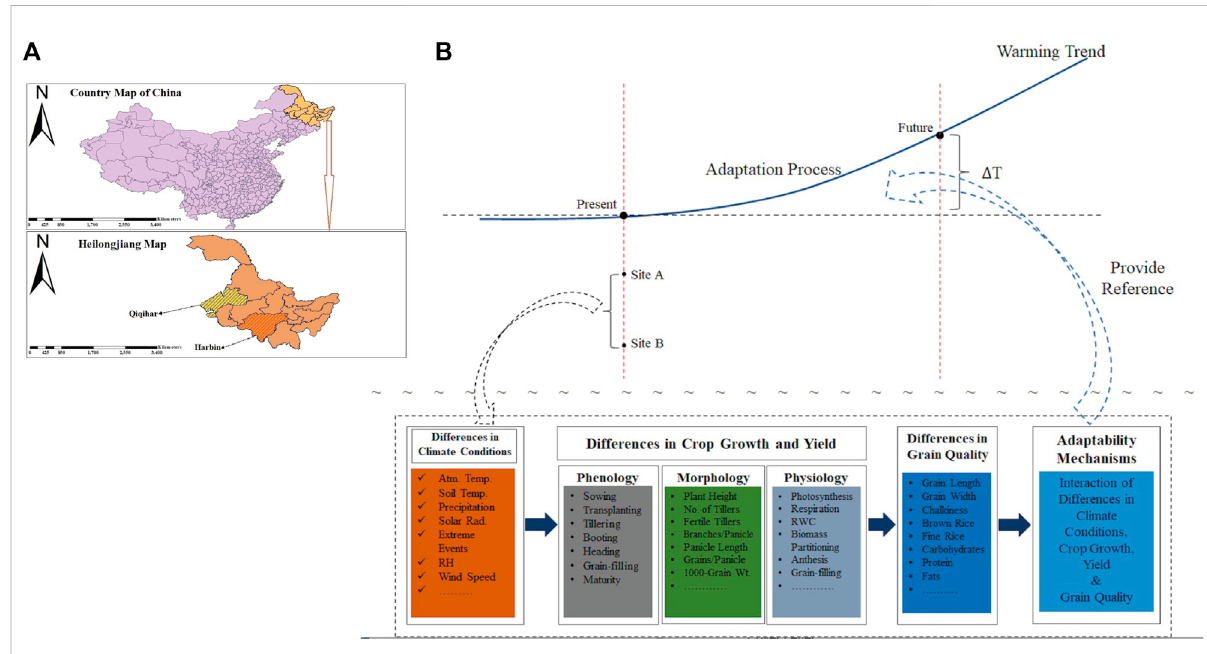
FIGURE 1 (A) Map of the study sites. (B) Rationale description of the study (site A: Harbin: site B: Qiqihar; Δ T: change in temperature: Atm Temp: atmospheric temperature; Rad: radiation; RH: relative humidity; RWC: relative water